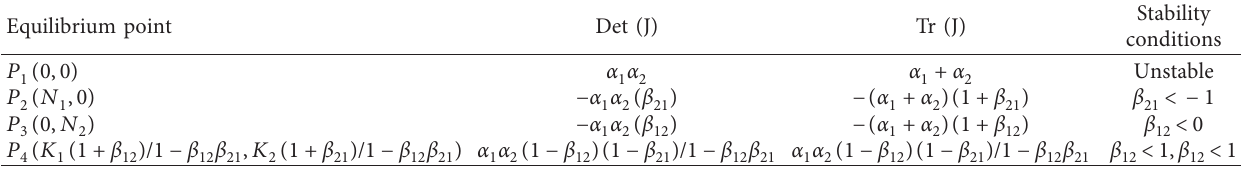
Table 1: Equilibrium point and stability conditions of innovation populations.